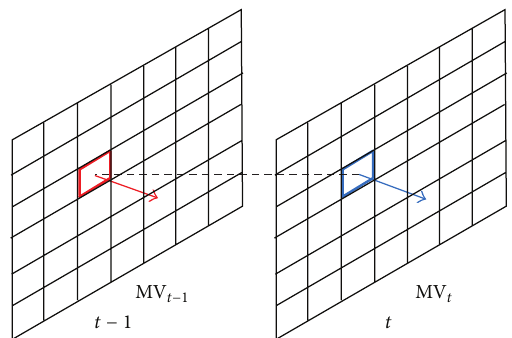
Figure 10: Corresponding-block prediction.